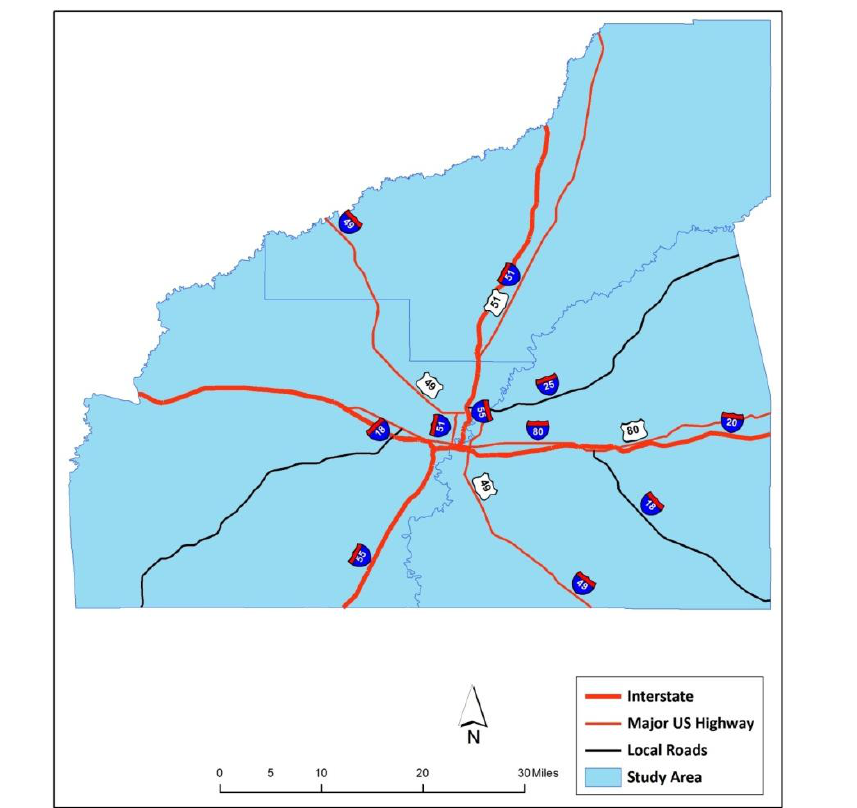
Figure 8. Major transportation routes through Hinds, Rankin and Madison County,